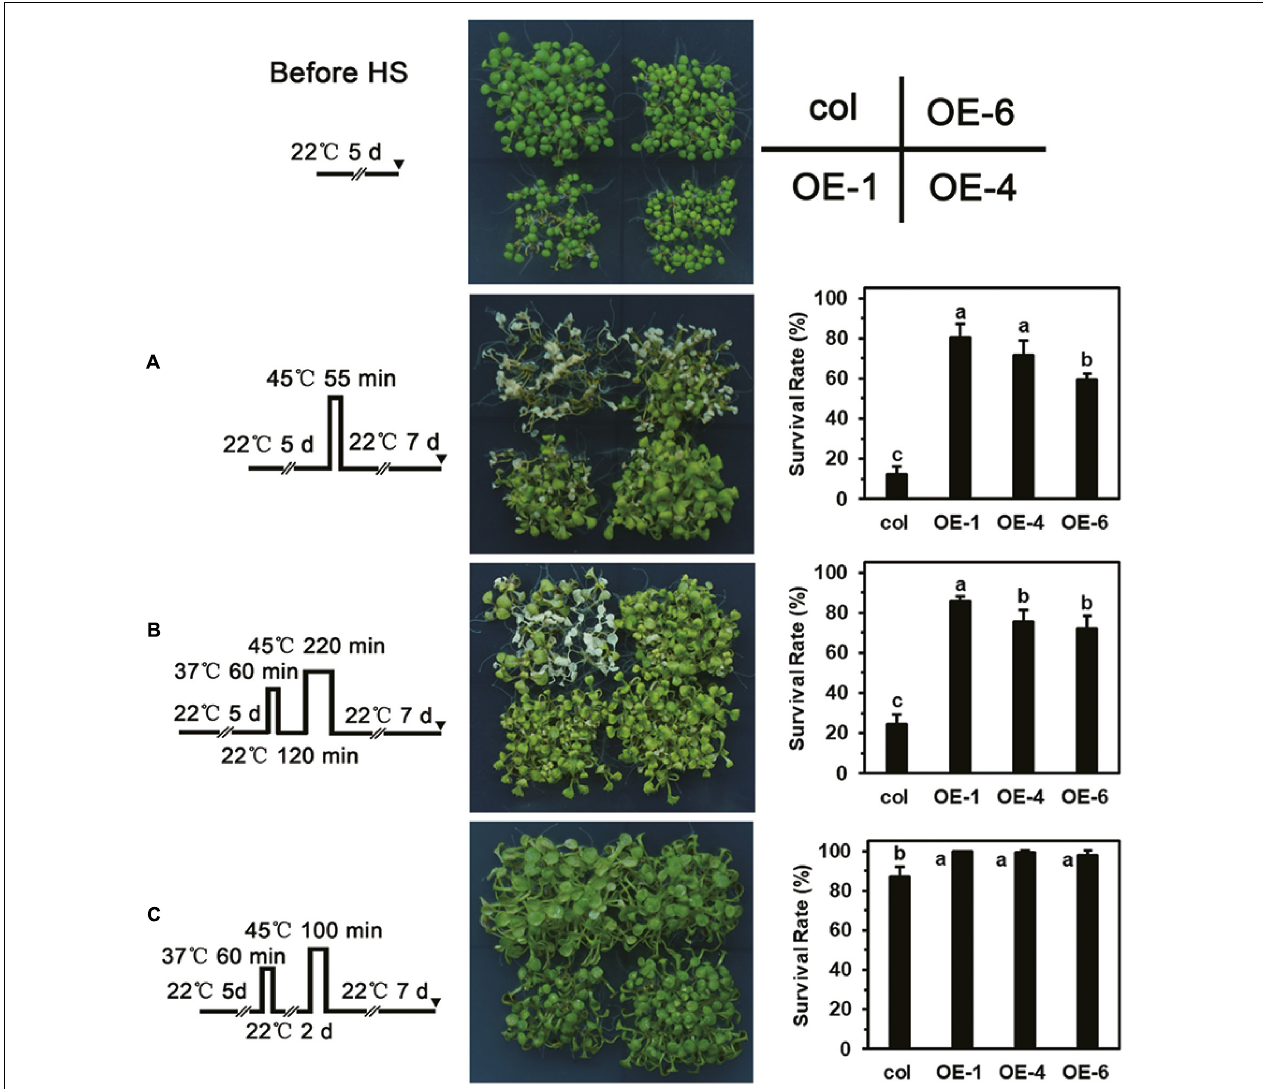
FIGURE 9 | Thermotolerance test of transgenic plants. Phenotypes of wild-type and transgenic (OE-1, OE-4, and OE-6) seedlings following treatment with the HS regimes (A–C) shown to the far left. (A) Five-day-old seedlings were directly exposed to 45 ◦ C to detect BT. (B) Five-day-old seedlings were first treated with a non-lethal temperature of 37 ◦ C for 60 min, followed by recovery for 2 h at 22 ◦ C, and then subjected to 45 ◦ C to detect ATSR. (C) Three-day-old seedlings were treated at 37 ◦ C for 60 min, then cultured under 22 ◦ C for 2 days, then exposed to 45 ◦ C to detect ATLR. Wild-type and transgenic plants were photographed, and survival rate was measured after 7 days of HS. Bars are means ± SD of three independent experiments. One representative result is shown. Each treatment included over 30 seedlings of each line. Different letters indicate significant differences among these lines (Student–Newman–Keuls test, P <